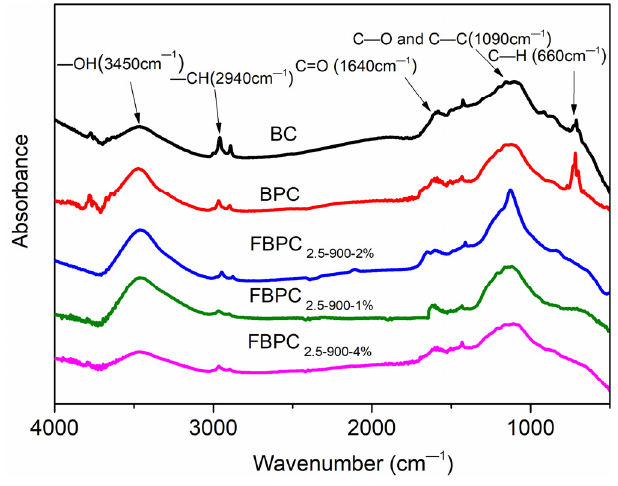
Figure 3. FTIR spectra of the BC, BPC 2.5-900 , FBPC 2.5-900-1% , FBPC 2.5-900-2% and FBPC 2.5-900-2% samples.